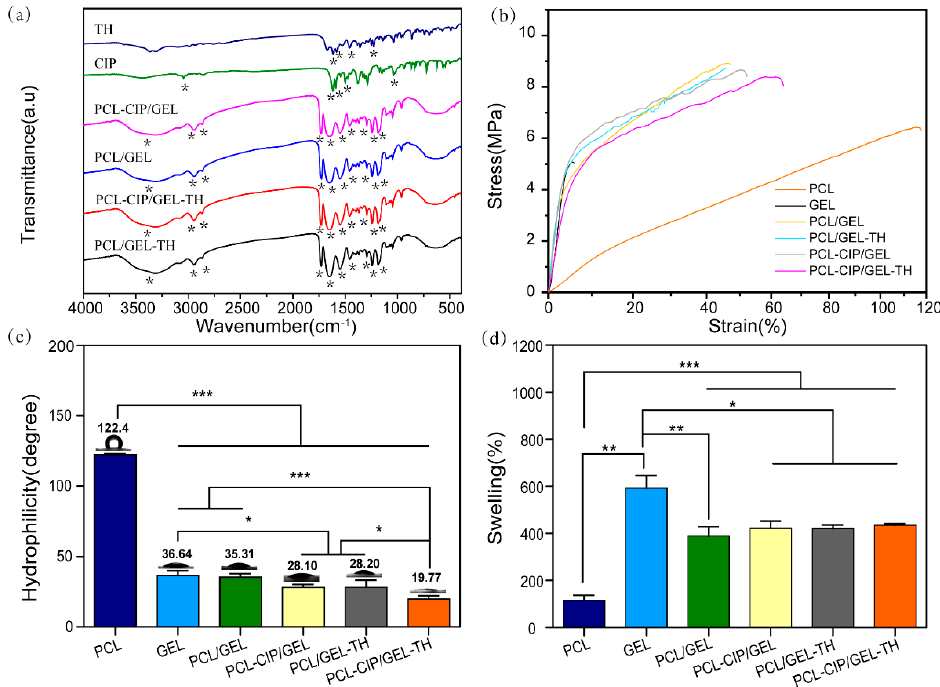
Figure 3. Physico-chemical characterization of different nanofibers. ( a ) FTIR spectra; ( b ) stress–strain curves; ( c ) water contact angles; ( d ) swelling behaviors. (n = 3); *— p < 0.05; **— p < 0.01; ***— p < 0.001.